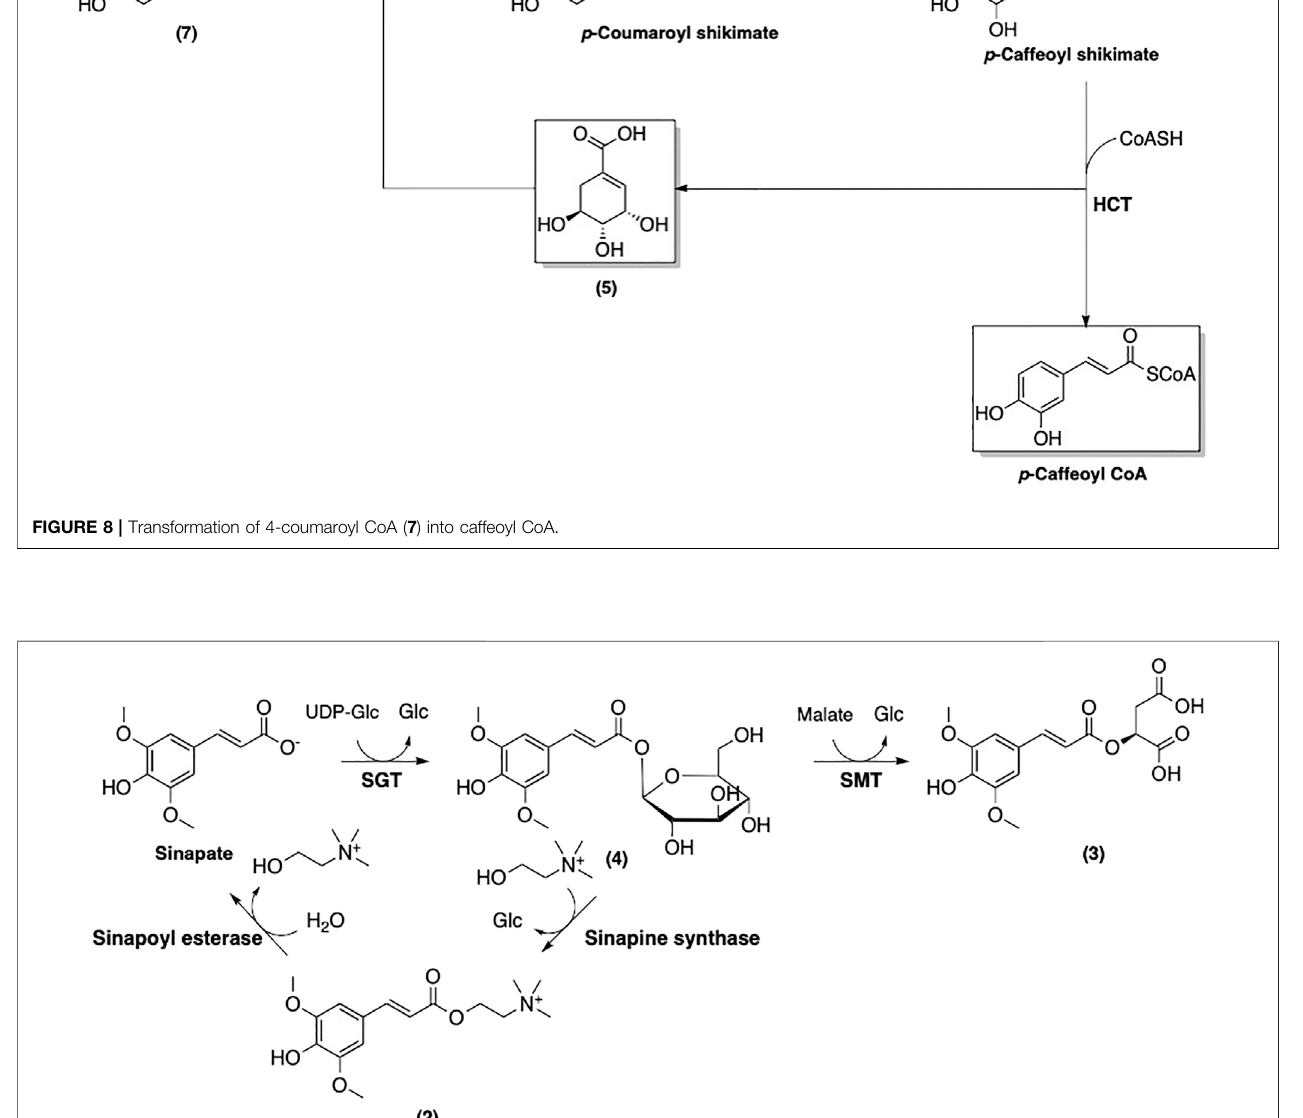
Frontiers in Chemistry |